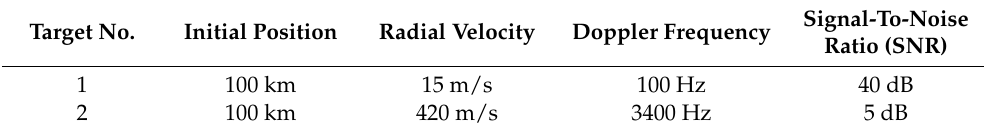
Table 1. Basic information of the targets set in Scenario 1. Target No. Initial Position Radial